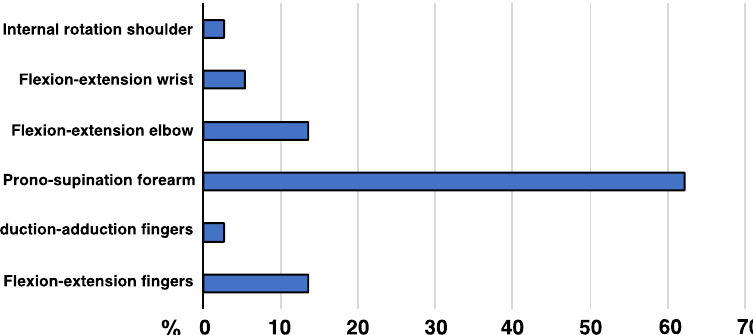
Figure 2. Main pattern of dystonic tremor of the upper limbs . Pronosupination was the most frequent tremor pattern observed while performing the most affected manual task. Table 2. Type of botulinum toxin, injected muscles, and botulinum toxin dose. Abobotulinum Toxin/A